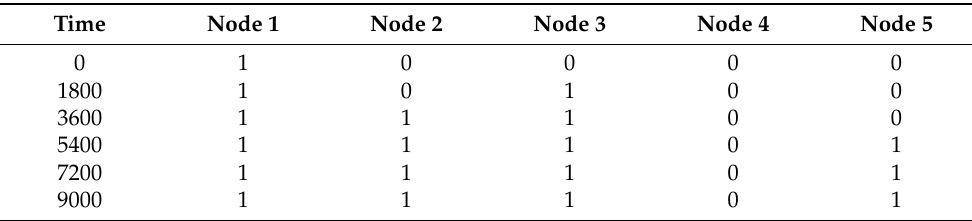
Table 1. Example of time and status matrix (TS matrix) of a